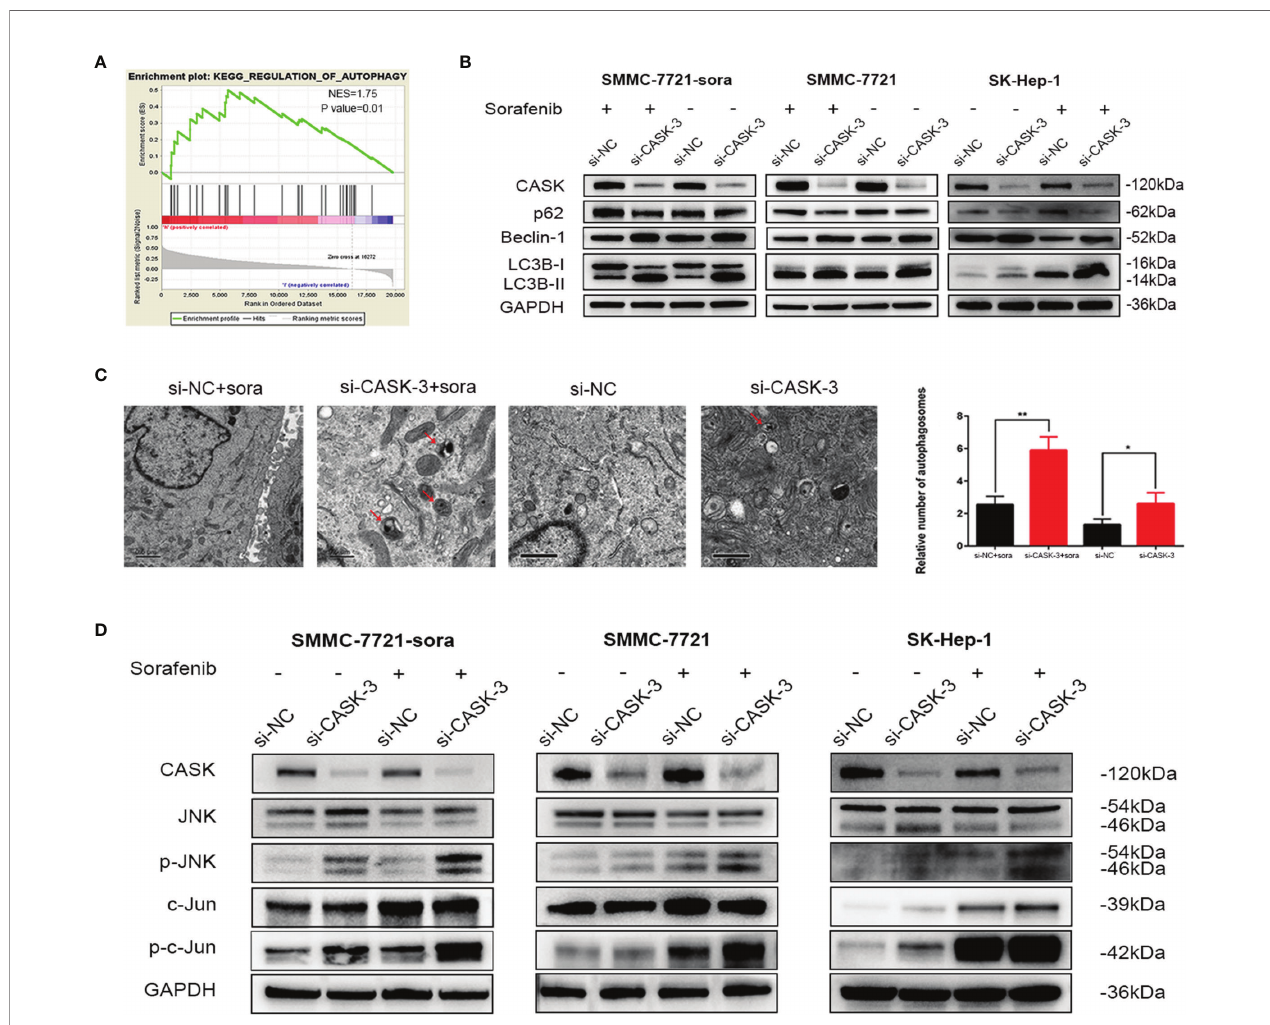
FIGURE 3 | CASK depletion increased autophagy and activated JNK/c-Jun signaling pathway. (A) Enrichment plots from Gene Set Enrichment Analysis (GSEA). The GSEA results indicated that the regulation of autophagy was differentially enriched in HCC with high CASK expression. (NES, normalized enrichment score) (B) Western blot analysis showing levels of autophagy-related proteins in CASK knockdown cells with the presence or absence of sorafenib (treated concentration: IC50 of sorafenib; treated time: 72 h) (C) Transmission electron microscopy (TEM) shows the number of autophagosomes were evaluated in CASK knockdown cells compared with control cells. (D) Western blotting analysis of the impact of CASK knockdown on the activity of JNK and c-Jun in SMMC-7721-sora, SMMC-7721 and SK-Hep-1 cells treated with or without sorafenib (sorafenib treated concentration: SMMC-7721: 10 m M, SMMC-7721-sora: 20 m M, SK-Hep-1: 15 m M; treated time: 72 h). *P < 0.05, **P <